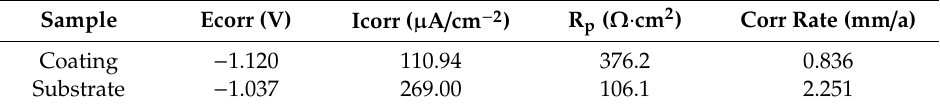
Table 3. Polarization curve parameters of Fe-based coating and HT 300 in 3.5% NaCl Solution.